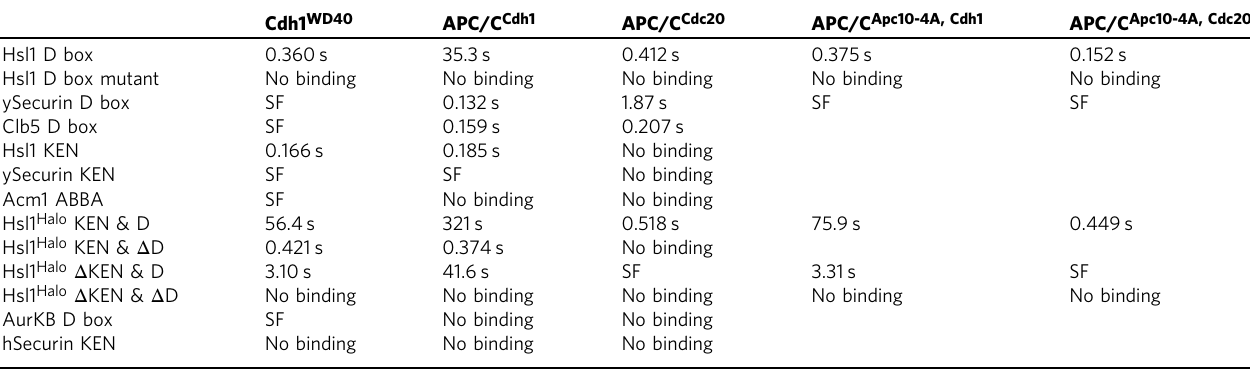
Table 1 Dwell times for substrate interactions with yeast